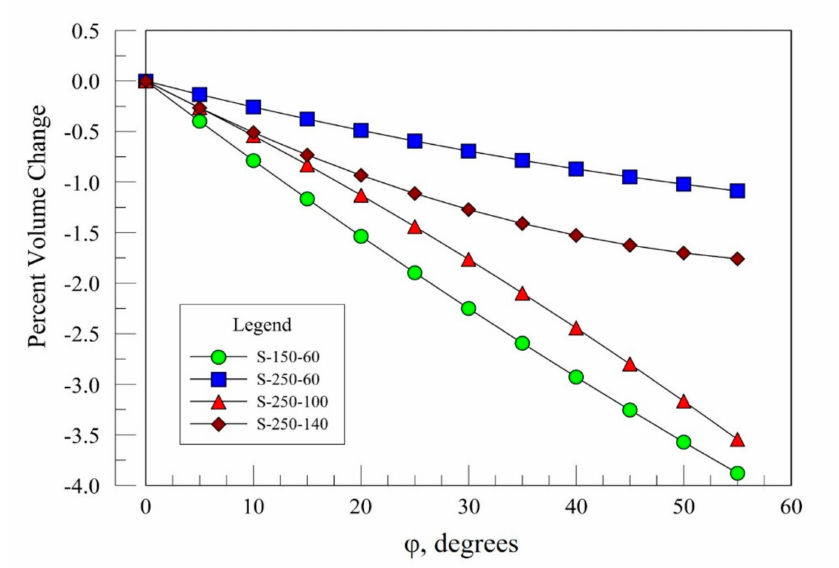
Figure 8. Percentage volume change for the tetragonal lattice based on area detector X-ray di ff raction data. In all cases, the volume decreased as the ϕ angle increased. The decrease is most significant for sample S-150-60, which had the highest c / a